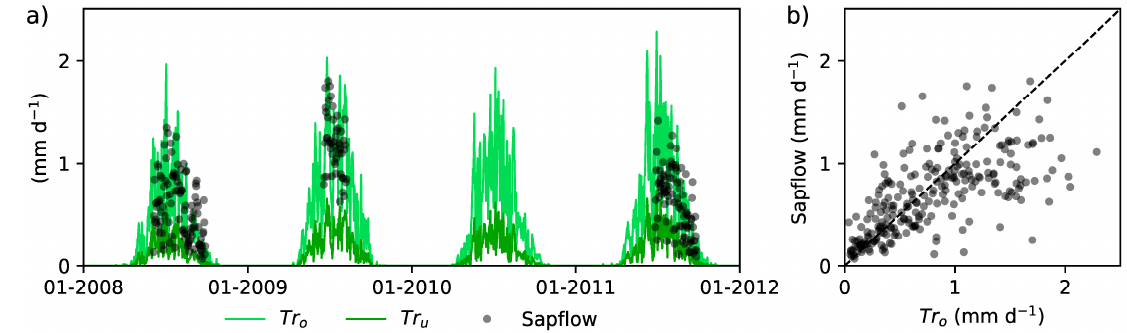
Figure A1. Predicted potential daily over- and understory transpiration (Tr o and Tr u , respectively), and measured average daily sapflow at Sattasuo ( a ), and predicted overstory transpiration against measured sapflow ( b ).